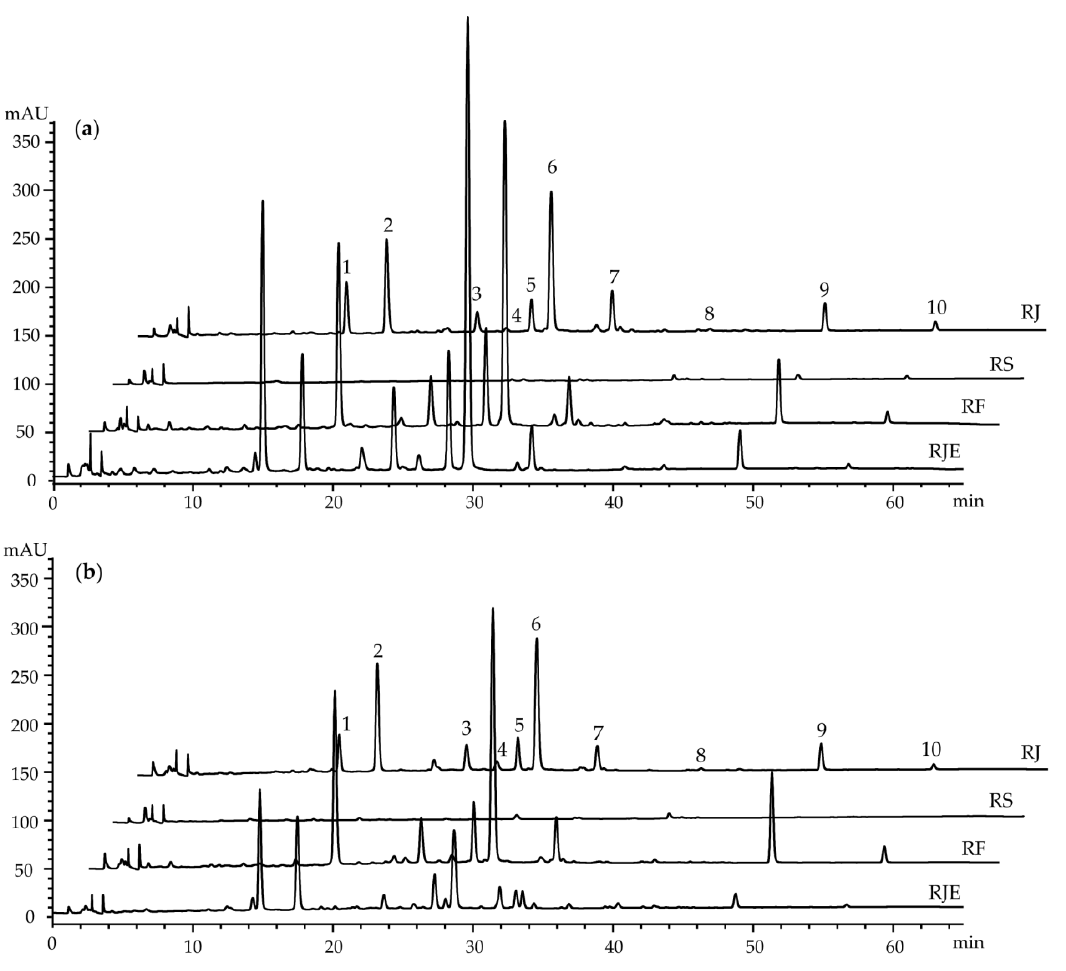
Figure 6. ( a ) LC chromatograms of the extracts from the roots collected before the flowering season; ( b ) LC chromatograms of the extracts from the root collected after the flowering season.